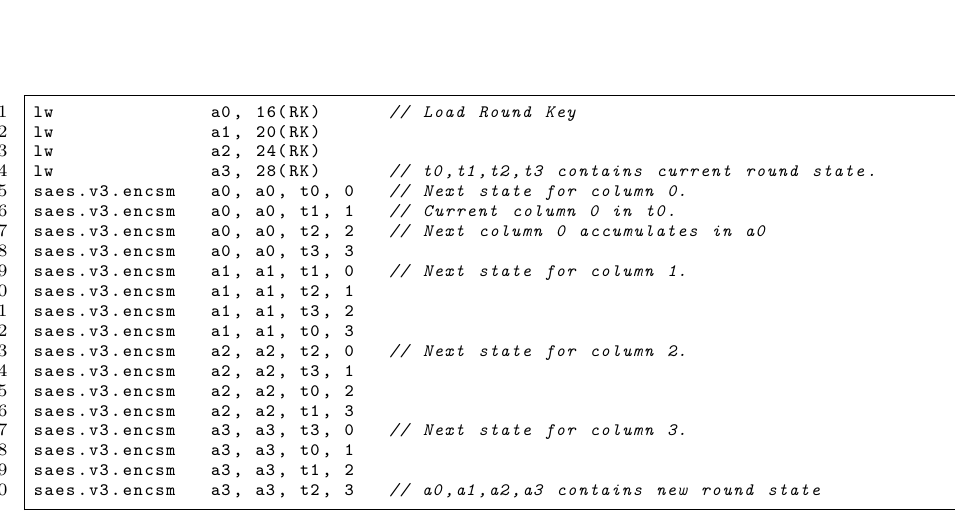
Figure 9: An AES encryption round implemented using V 3 .